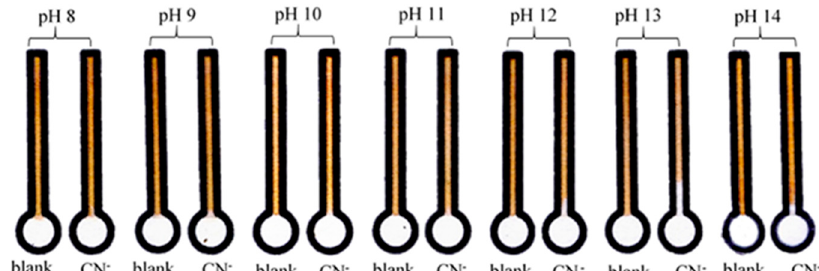
Figure 3. pH effect in the range of 8–14 with the present of CN − 10 mg L − 1 .